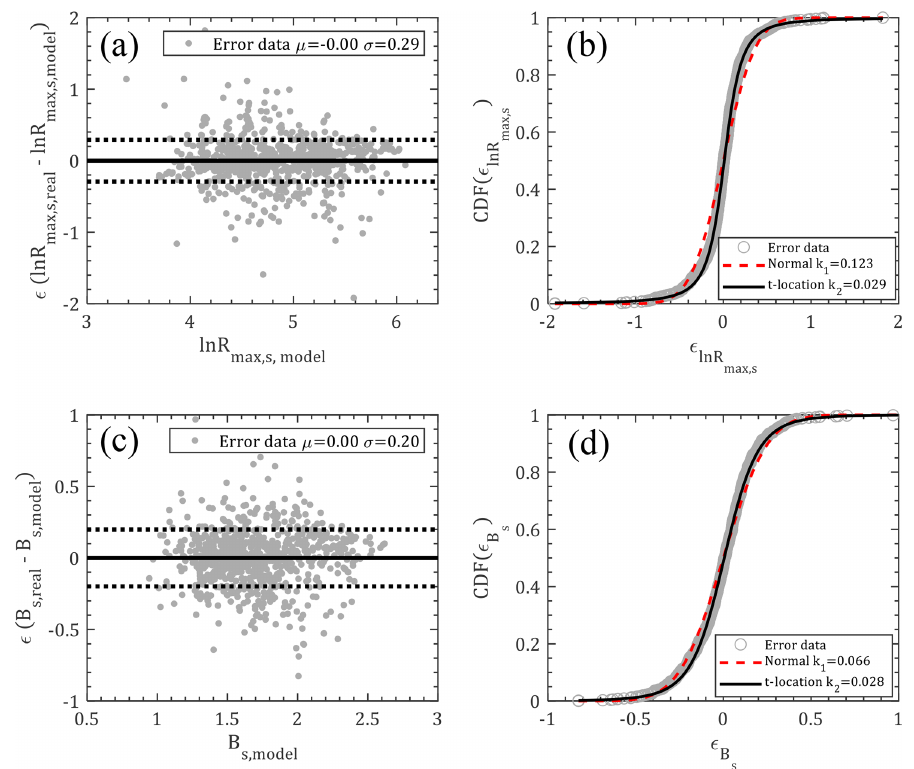
Figure 9. Model errors for ln R max , s and B s : (a) scatterplot ( ε ln R